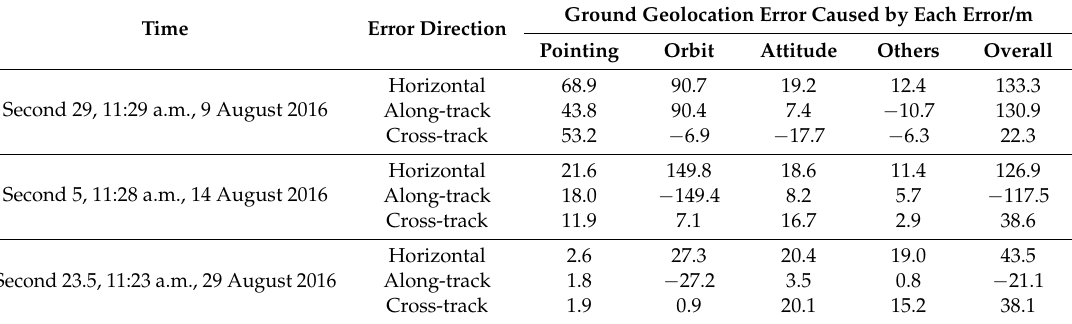
Table 5. Accuracy analyses of the prediction